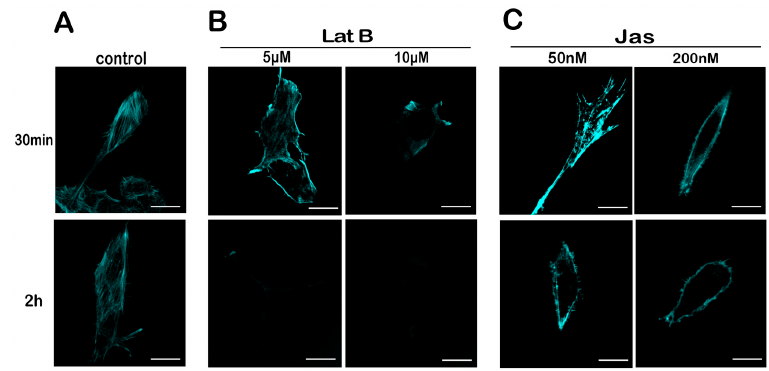
Figure 4. The concentration-dependent effects of Lat B and Jas on the actin cytoskeleton. ( A ) Untreated MN9D cells were stained with phalloidin at the given time points; ( B ) MN9D cells were stimulated with Lat B at the indicated concentrations and time points; ( C ) MN9D cells were stimulated with Jas at the indicated concentrations and time points. (Scale bar = 5 μ m).